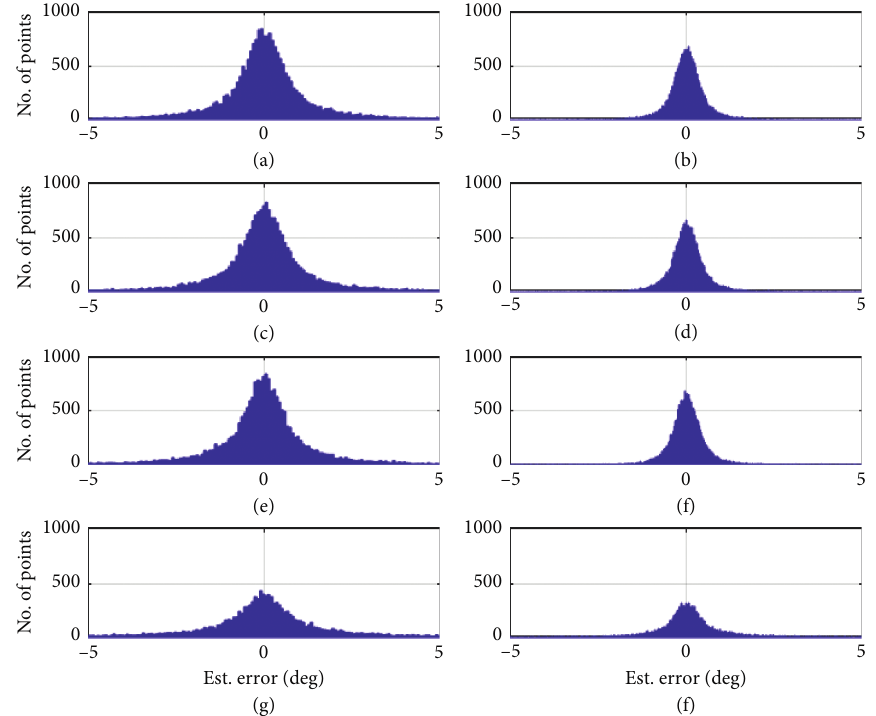
Figure 12: The histograms of Az (left column) and El (right column) estimation errors, when − 10 dB ≤ SNR ≤ 0dB with 1025 snapshots. (a, b) WF-1; (c, d) WF-2; (e, f) WF-3; (g, h) WF-4.